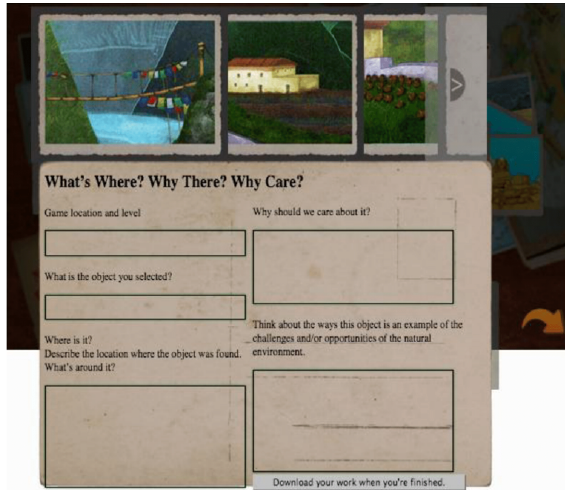
Figure 8. What’s where/there? Why there? Why care? activity.